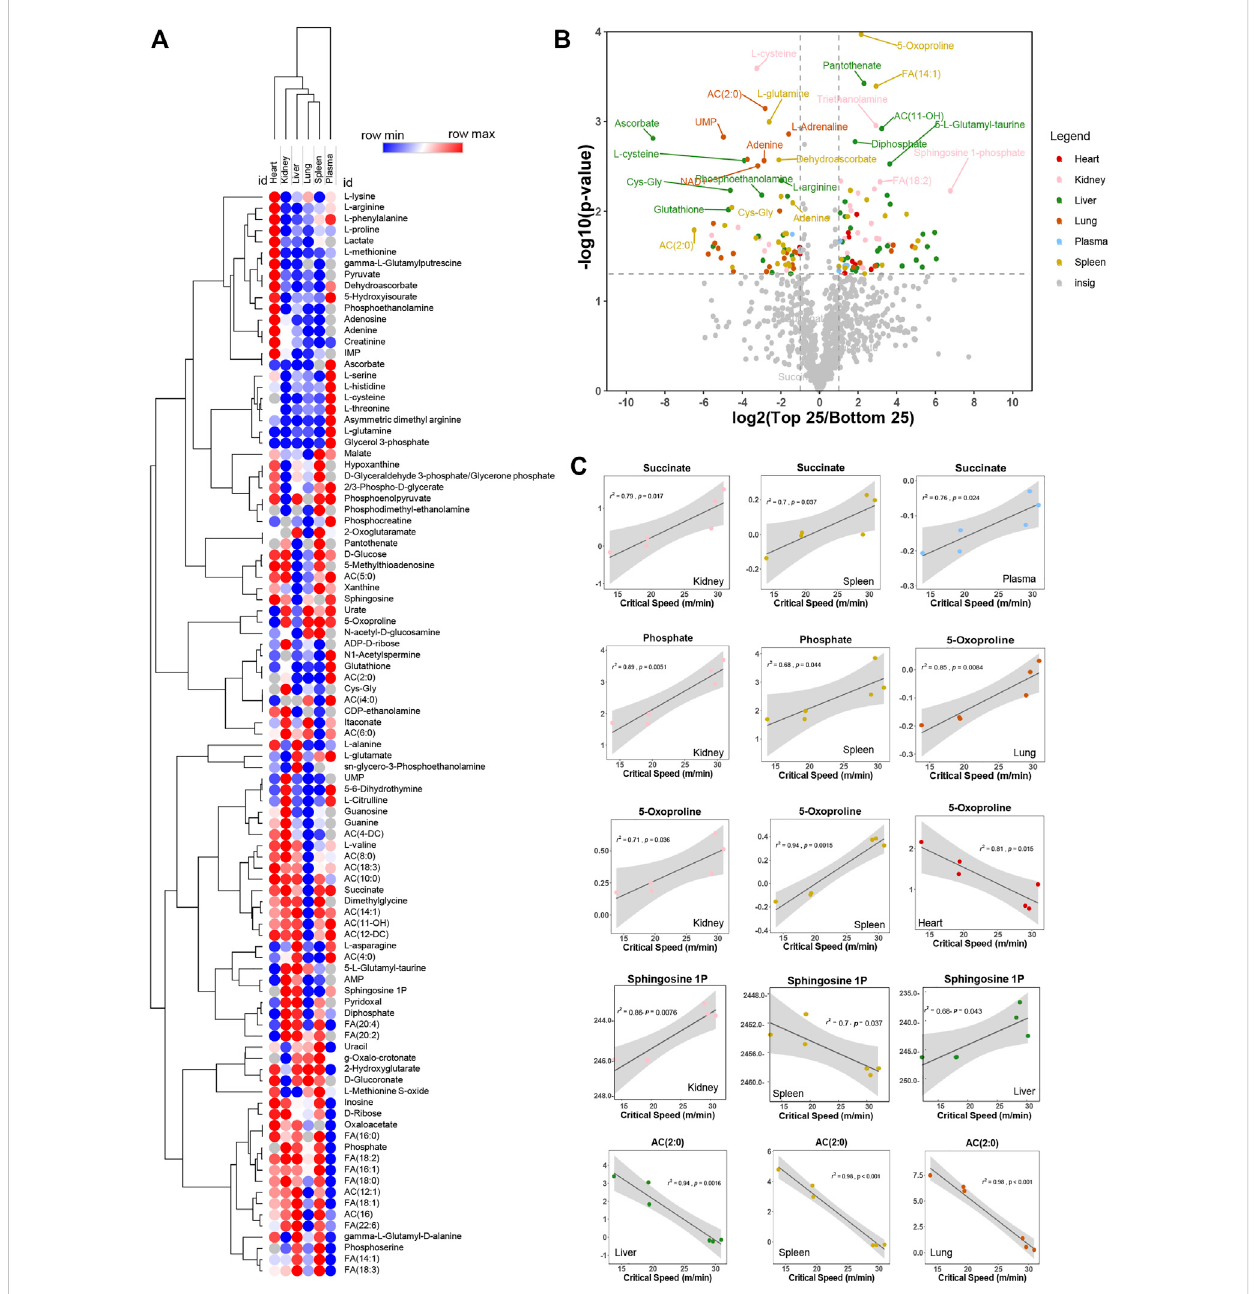
Metabolites correlate negatively and positively with critical speed. In (A) , heat map of top correlations to bottom correlations with critical speed. In (B) , volcano plot exhibiting metabolite levels that were increased in Top25 or Bottom 25 CS mice. The x -axis shows log2 transformed average fold changesofTop25/Bottom25CSmice.Whilethe y -axisshows-log10transformed p -valuesforeachcorrespondingfoldchange.Dashedverticallinesare positioned at ± x = 1 [log2(2) = 1, so fold change = 2] and the horizontal line is positioned at y = 1.3 [-log10(0.05)]. Metabolites showing log2transformedfoldchangesgreaterthan1,and-log10transformed p -valuesgreaterthan1.3wereconsideredsigni fi cantlyenrichedinTop25CSmice. Metabolites showing log2 transformed fold changes less than − 1, and -log10 transformed p -values greater than 1.3 were considered signi fi cantly enriched in Bottom25 CS mice. Signi fi cantly enriched metabolites were color coded based on the originating matrix type, as indicated in the legend. In (C) , linear regressions for signi fi cant hits as identi fi ed in the volcano plot both for negative correlation and positive